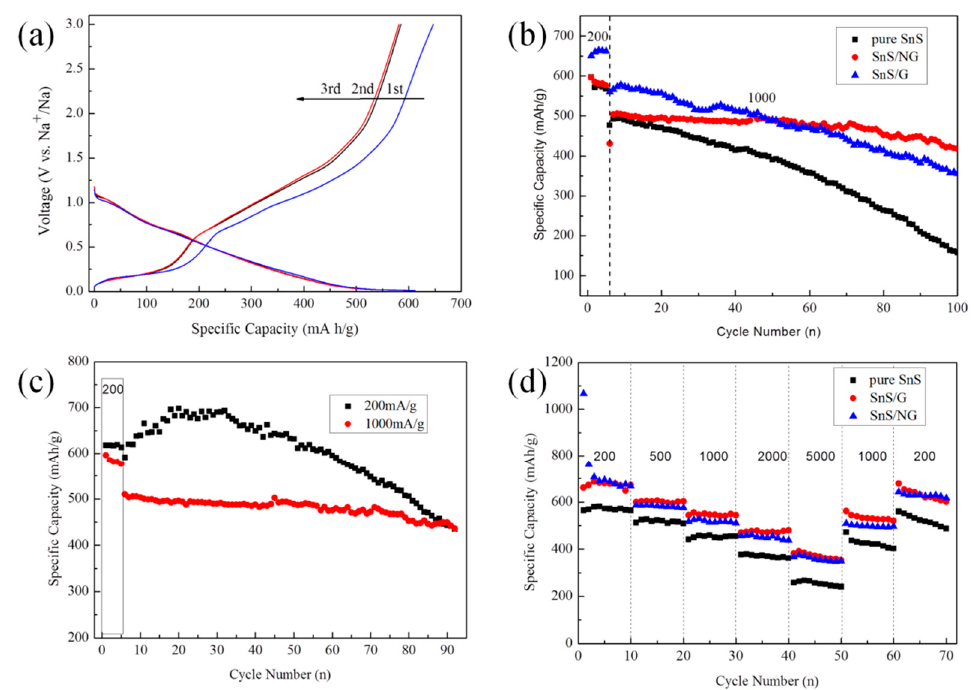
Figure 6. ( a ) Discharge/charge profiles of SnS/NG at different cycles at 200 mA/g. ( b ) Cycle stability of SnS/NG, SnS/G and SnS at 1000 mA/g. ( c ) Cycle stability of SnS/NG at 1000 mA/g and 200 mA/g. ( d ) Rate performance of SnS/NG, SnS/G and SnS.